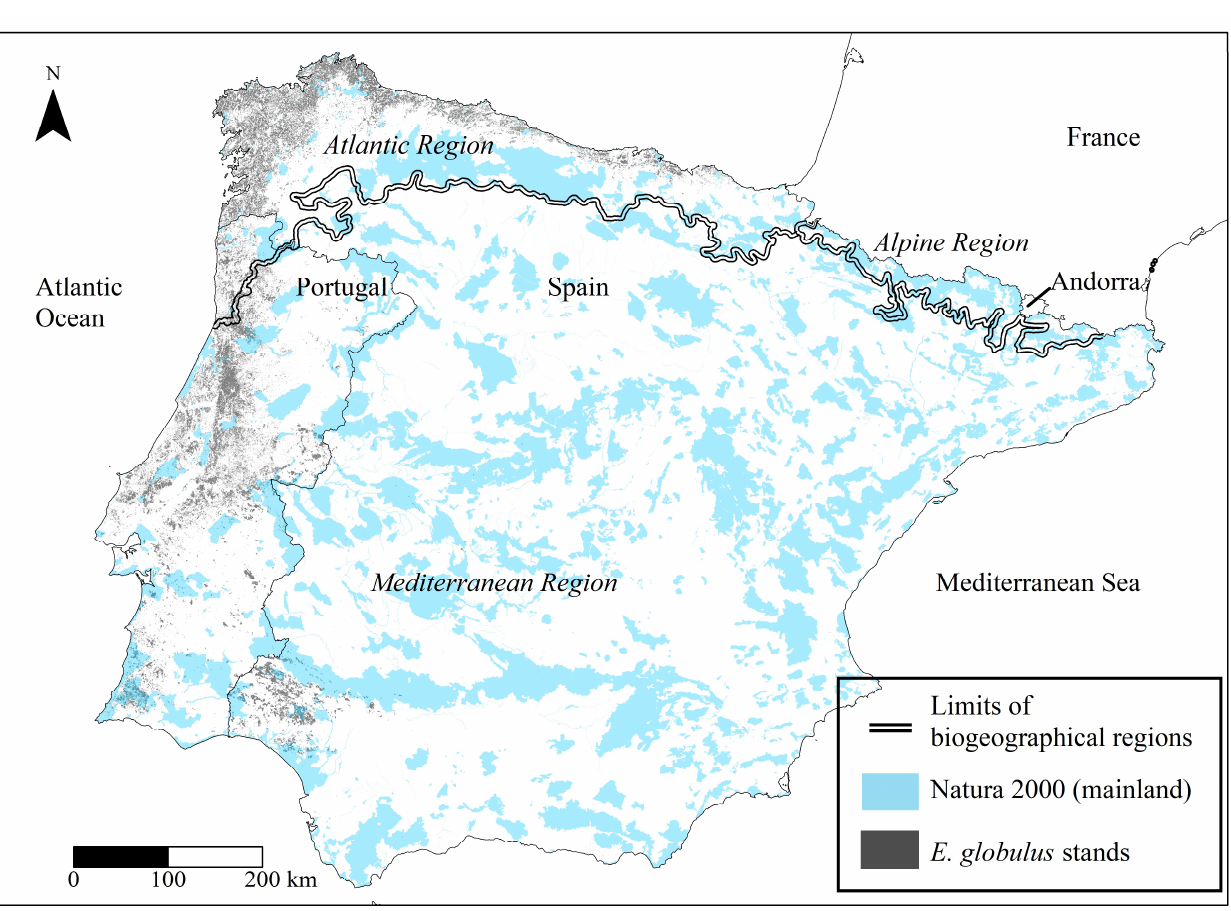
Figure 1. Eucalypts globulus Labill. distribution, biogeographical regions (italic text) and terrestrial protected area from the Natura 2000 network in the Iberian Peninsula (Portugal and